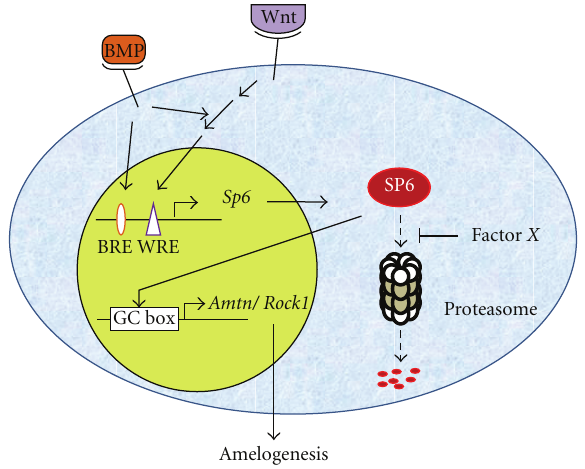
Figure 5: Proposed model of Sp6 expression and function coupled with amelogenesis in dental epithelial cells. BMP and Wnt signals can enhance Sp6 promoter activity, resulting in the enhancement of Sp6 mRNA expression (6). The level of SP6 protein expression is regulated by proteasome activity, which would be physiologically controlled by a MG132-equivalent factor X. Stabilized SP6 protein is transferred into the nucleus and regulates the expression of amelotin and rock1 mRNA. BRE: BMP signal-responsive elements; WRE: Wnt signal-responsive